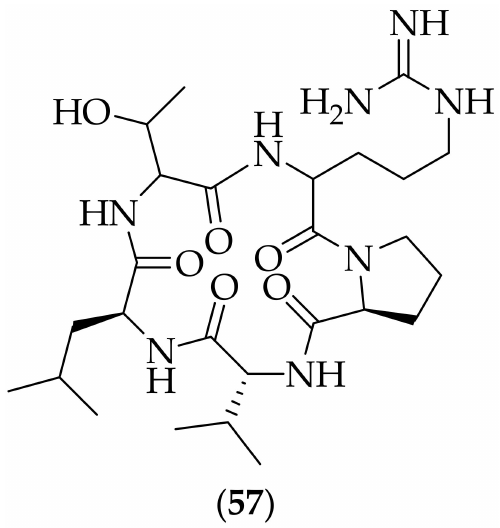
Figure 38. Antifungal cyclic pentapeptide ( 57 ).